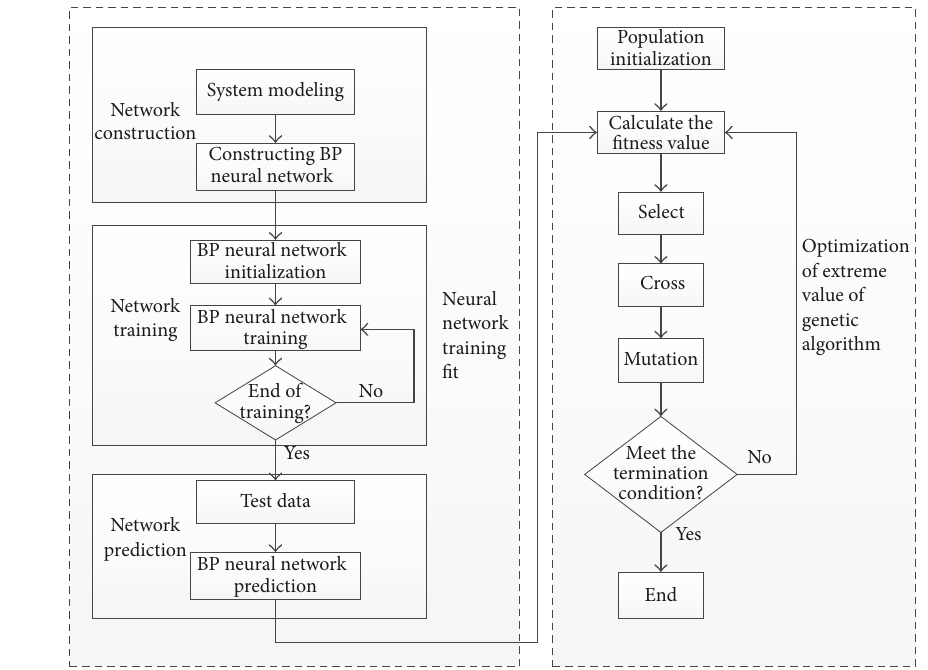
Figure 9: Neural network and genetic algorithm flowchart.